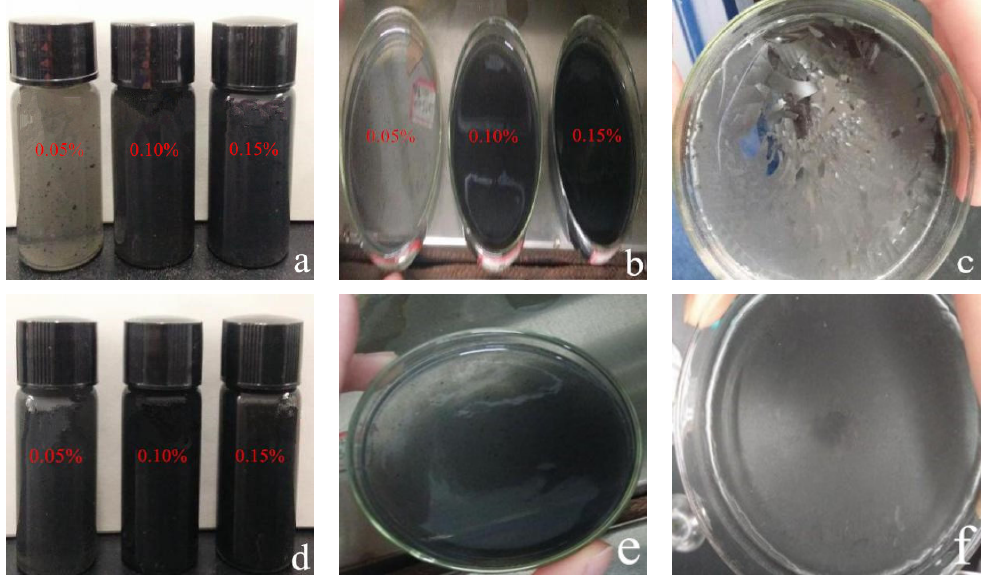
Figure 3. Visual appearance of WPI fibril–carbon nanocomposites: ( a , b ) WPI fibril–CNT composites in glass vials and dishes with different CNT concentrations; ( c ) WPI fibril–CNT (0.10 wt.% CNT) composites after drying at 60 °C for 48 h; ( d ) WPI fibril–CNO composites in glass vials with different CNO concentrations; ( e , f ) WPI fibril–CNO composites (0.10 wt.% CNOs) before and after drying at 60 °C for 48 h.